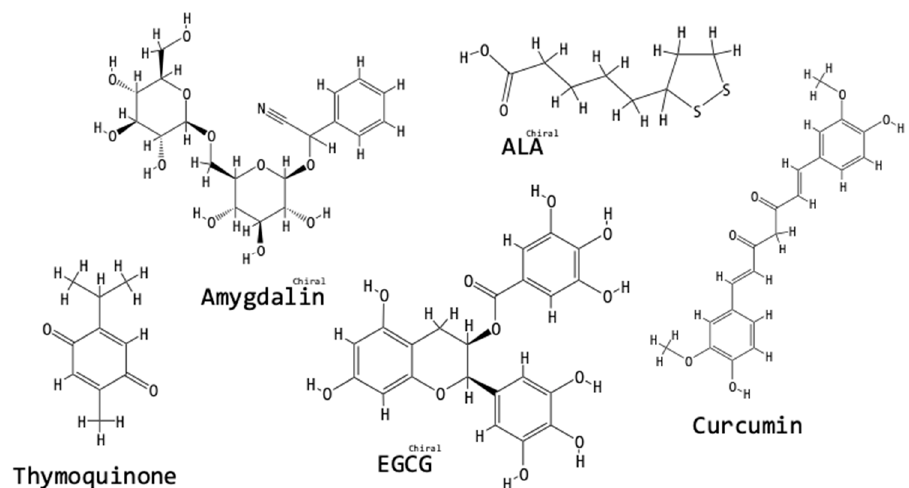
Figure 3. Chemical structures of vitamin and antioxidant compounds tested for fibrosis-ameliorating activity in the context of the UUO model. The structures were obtained from the PubChem database [60]: the “PubChem CID” for each compound has been listed in the text next to the compound’s name.